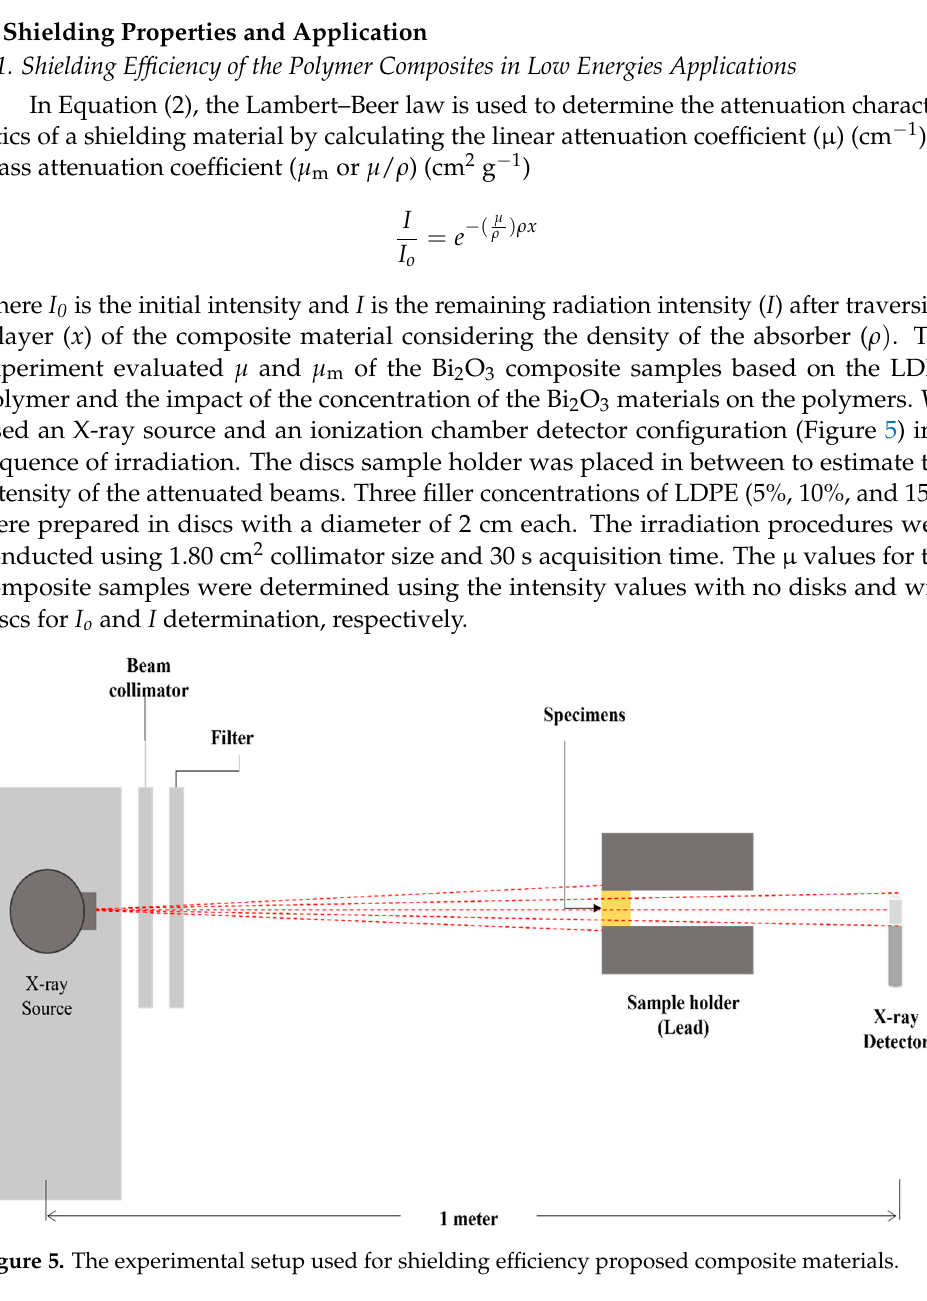
Table 6. Narrow X-ray spectrum qualities used (Adopted from ISO-4037 [42]).